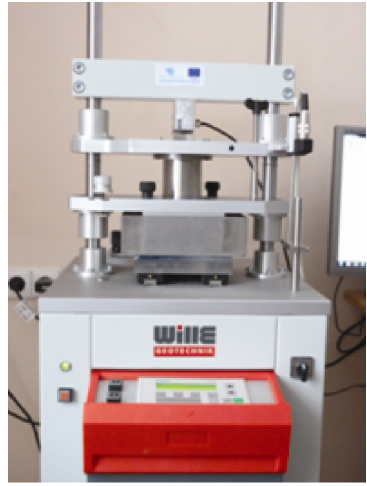
Fig. 1. Universal oedometer apparatus ADS 1/3 (Wille Geotec Group 2010) Amongst negative side effects met when